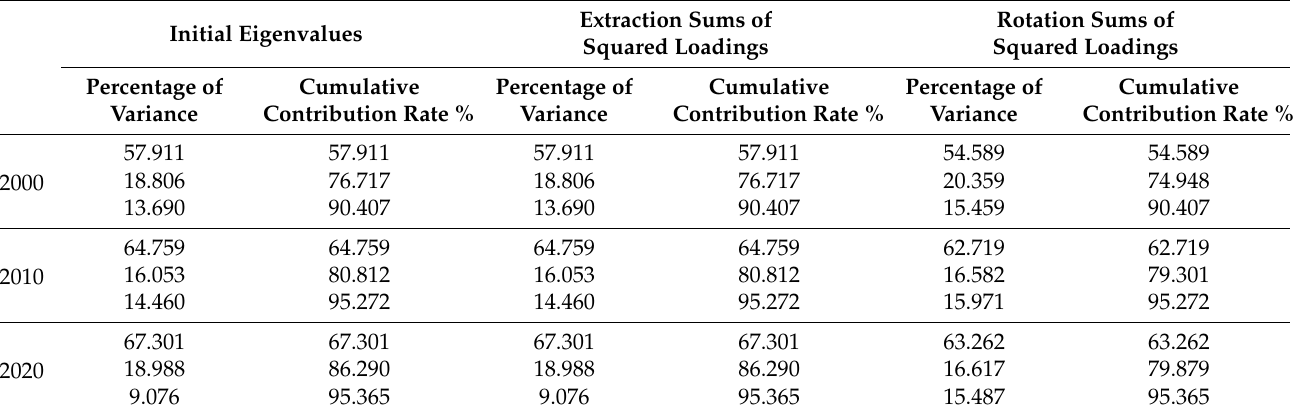
Table 4. Total variance table of principal components in each year in Chaohu Lake